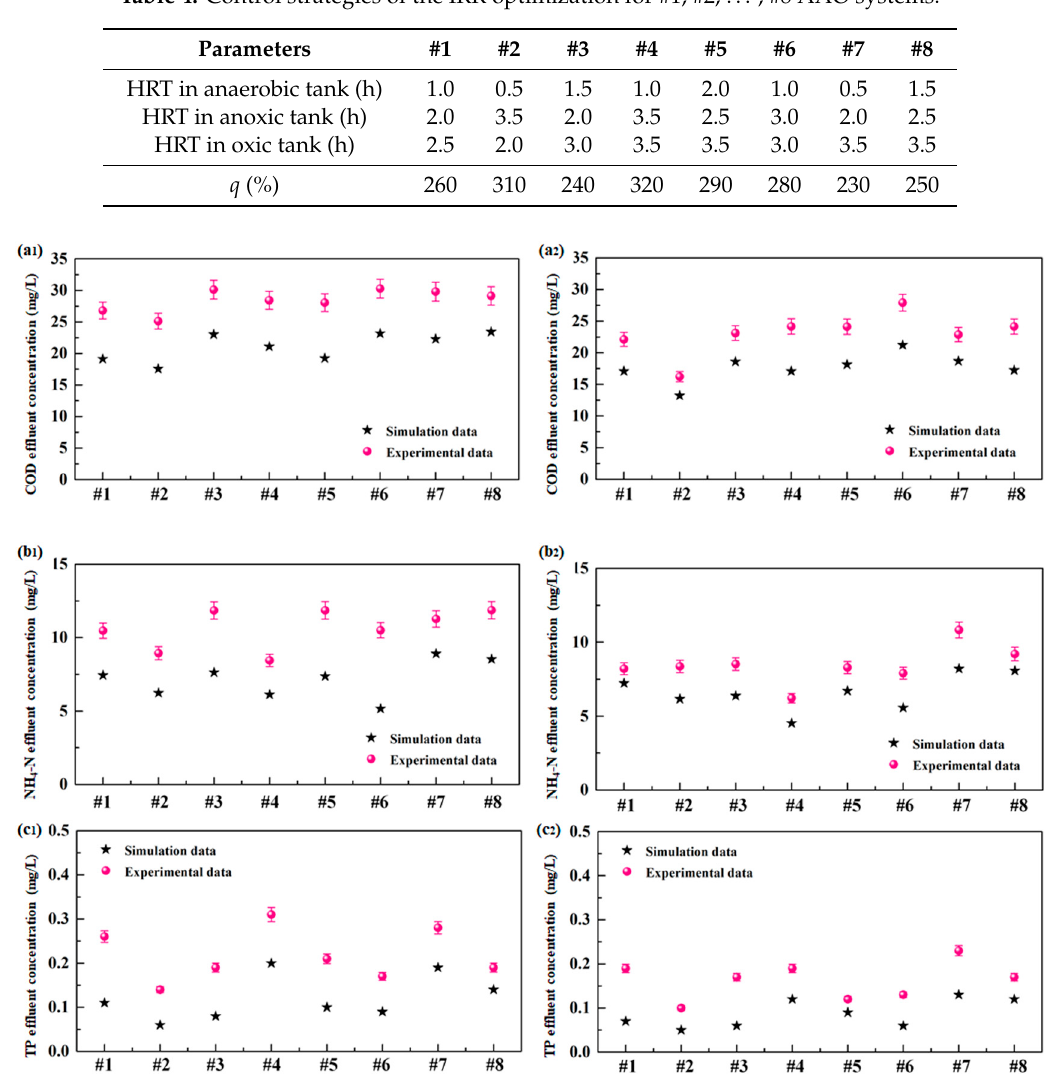
Figure 8. Model simulations and experimental results for eight AAO systems: ( a 1 , a 2 ) COD effluent concentrations; ( b 1 , b 2 ) NH 4 -N effluent concentrations; and ( c 1 , c 2 ) TP effluent concentrations of the HRTs optimization and the IRR optimization.